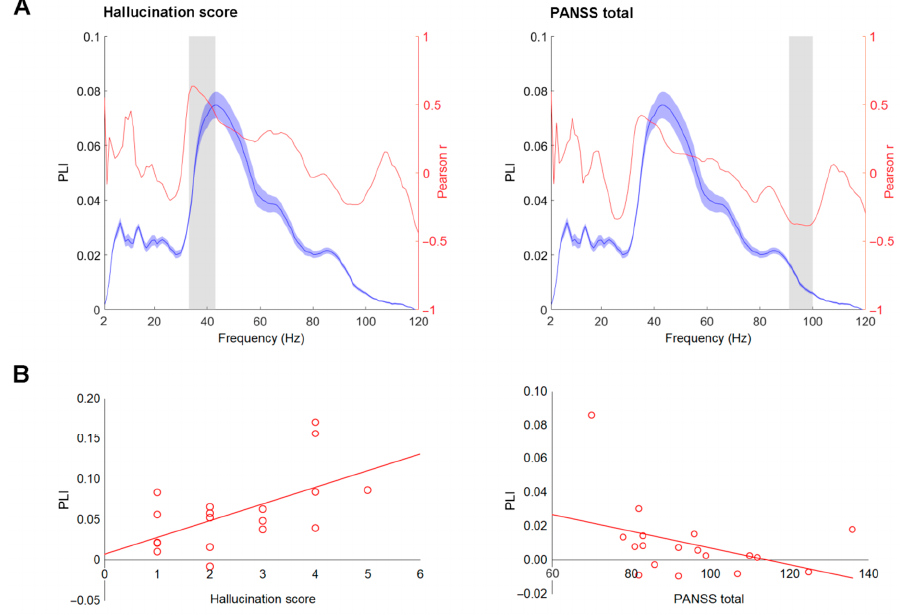
Figure 3. Correlation between envelope following responses (EFR) measures and clinical variables. ( A ) Phase-locking index (PLI) curves (blue) and Pearson r values (red) between PLI and hallucination scores and Positive and Negative Syndrome Scale (PANSS) total scores in schizophrenia group. The shaded blue areas around the curve represent standard deviations. The frequency windows where significant correlation was observed, as assessed by the bootstrap, are marked by grey shaded areas. ( B ) Scatterplots of PLI values averaged within the significant window (depicted in part A) against hallucination and PANSS total